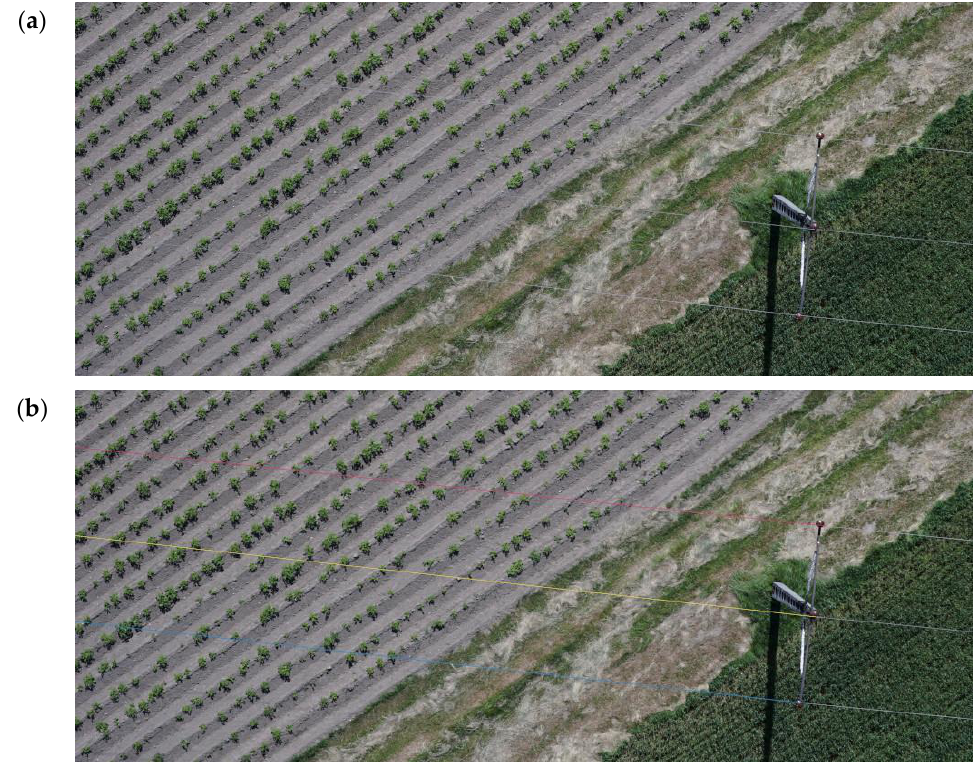
Figure 16. Detection results of the wires: ( a ) original image; ( b ) processed image with highlighted wires detected. Table 6. The results of processing Datasets I and